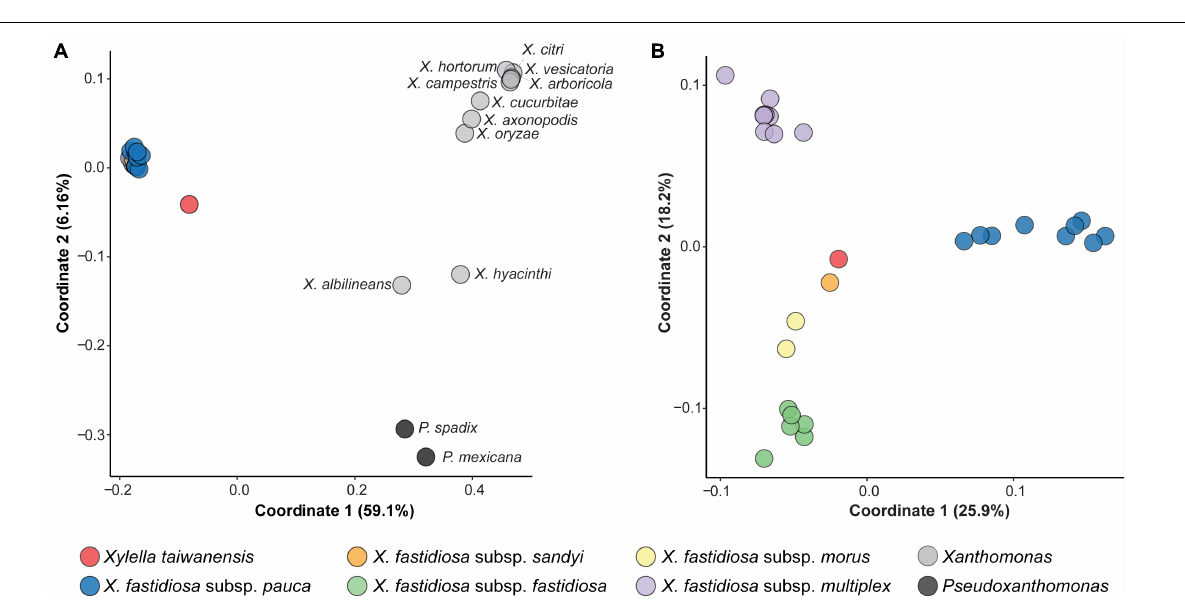
FIGURE 3 | Principal coordinates analysis of gene content dissimilarity. The % variance explained by each coordinate was provided in parentheses. (A) Based on the 11,455 homologous gene clusters found among all 40 Xanthomonadaceae genomes analyzed in this work. (B) Based on the 5,395 homologous gene clusters found among the 28 Xylella genomes analyzed in this